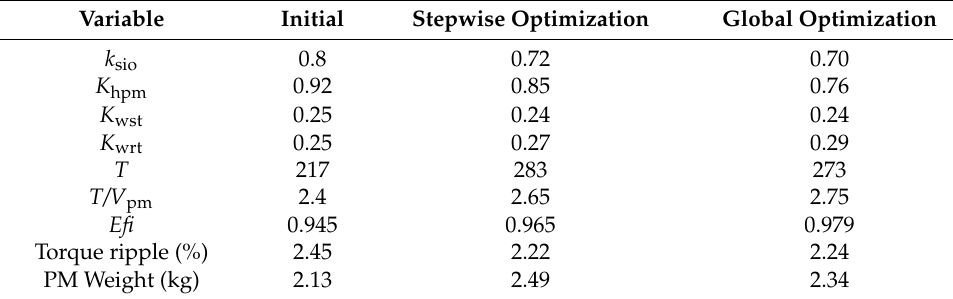
Table 4. Design parameters of the FSPM generator.